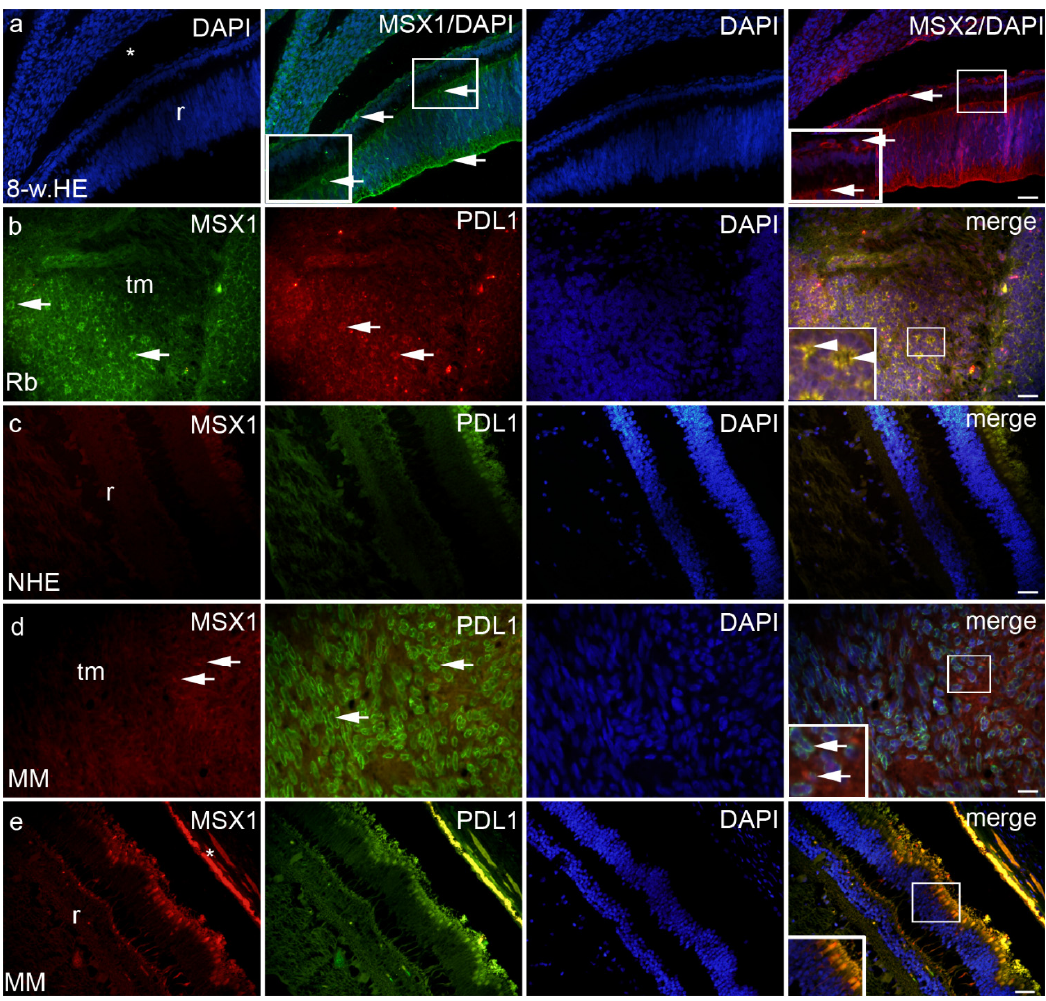
Figure 4. MSX1, MSX2 and PDL1 can be seen in the eye section of an 8-week human embryo–8-w.HE ( a ), retinoblastoma–Rb ( b ), normal human eye-NHE ( c ), myxoid melanoma-MM ( d , e ), inset on panel e—photoreceptors; r—retina, *—choroidea, tm—tumor tissue. Co-localization of MSX1 and PDL1 positive cells (arrowheads in the inset of magnification frame). Double immunofluorescence staining to MSX1 (first column), PDL1 (second column), DAPI (third column), MSX2 and merge (fourth column)—exceptions from this path are labelled on the panel. Magnification frames provide detail with positive cells (arrows) or co-localization (arrowheads). Scale bar for all panels is 25 μ m.